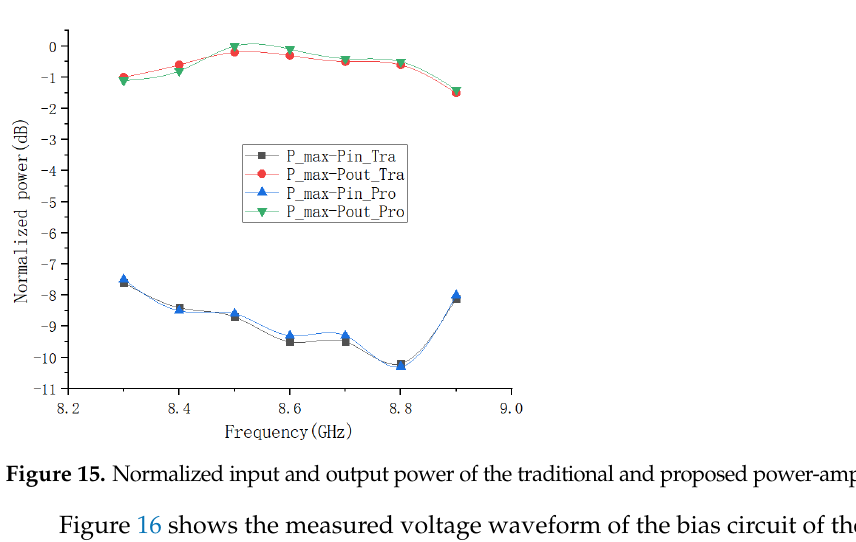
of the proposed power-amplifier system is 0.686.